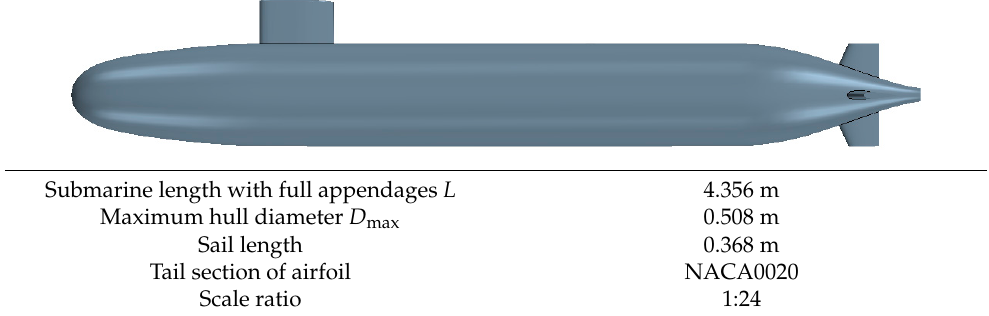
Table 1. Main parameters of SUBOFF.